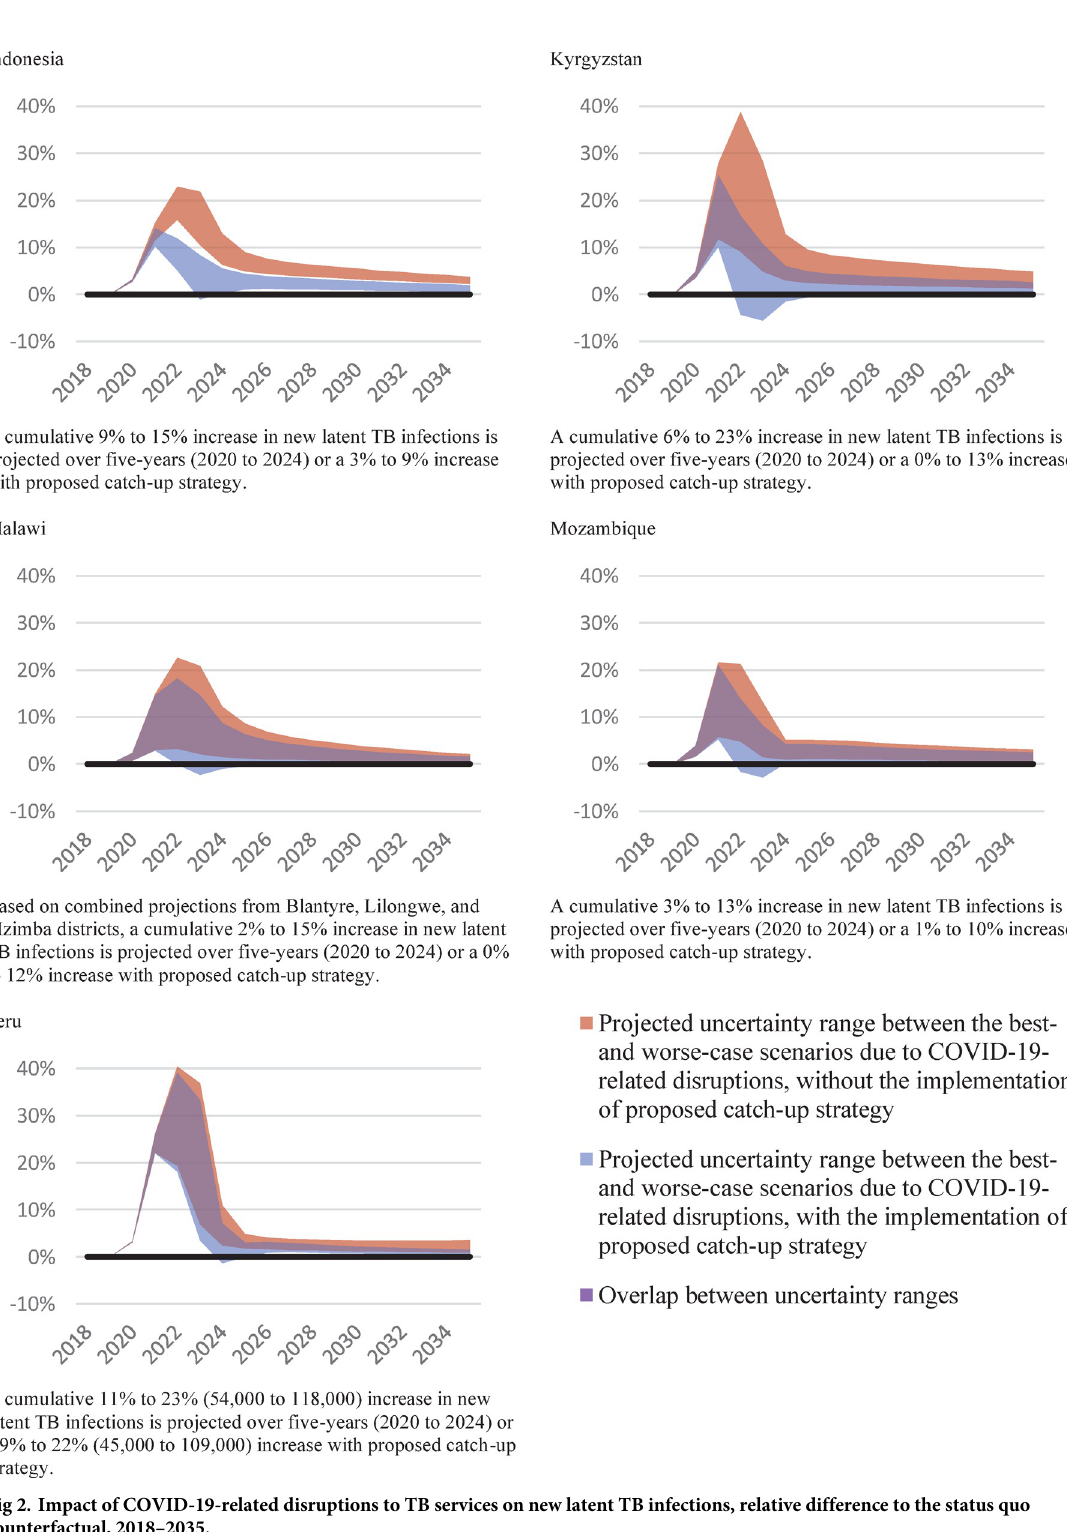
PLOS Global PublicHealth | https://doi.org/10.1371/journal.pgph.0000219 March 30,